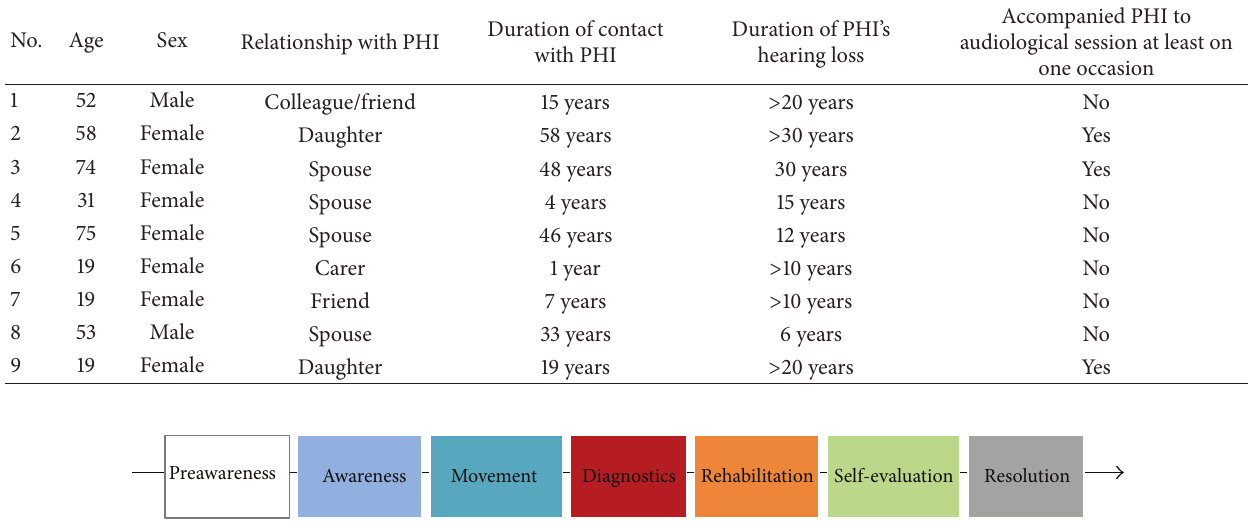
Table 1: Demographic details of communication partners of PHI.